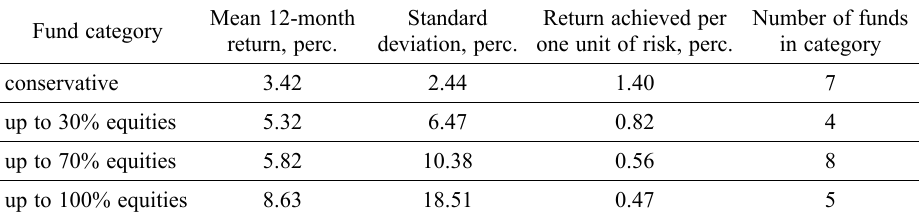
Fig. 3. 12-month rolling returns of pension funds Table 7. Mean returns and standard deviations used in hypothesis testing